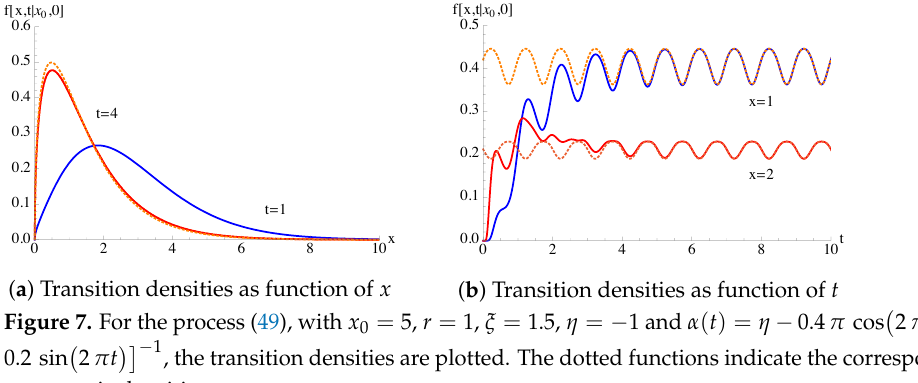
(cid:0) (cid:1)(cid:2) 2 π t 1 +